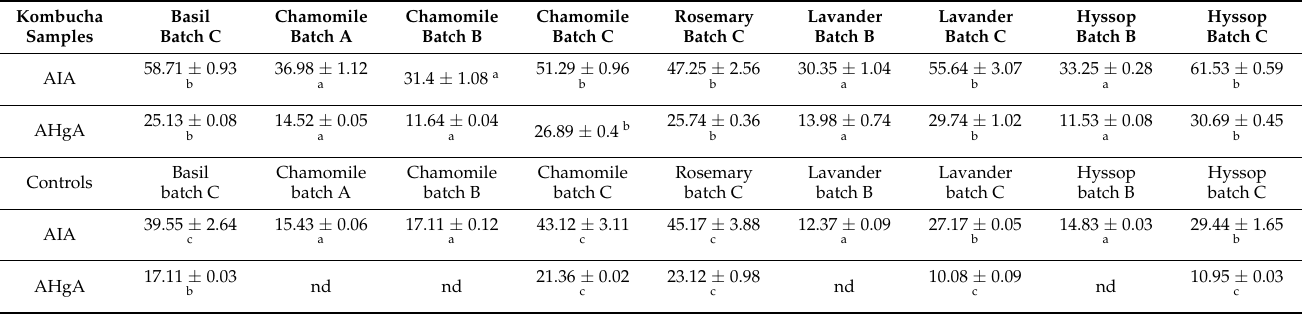
Table 5. Pharmacological activities